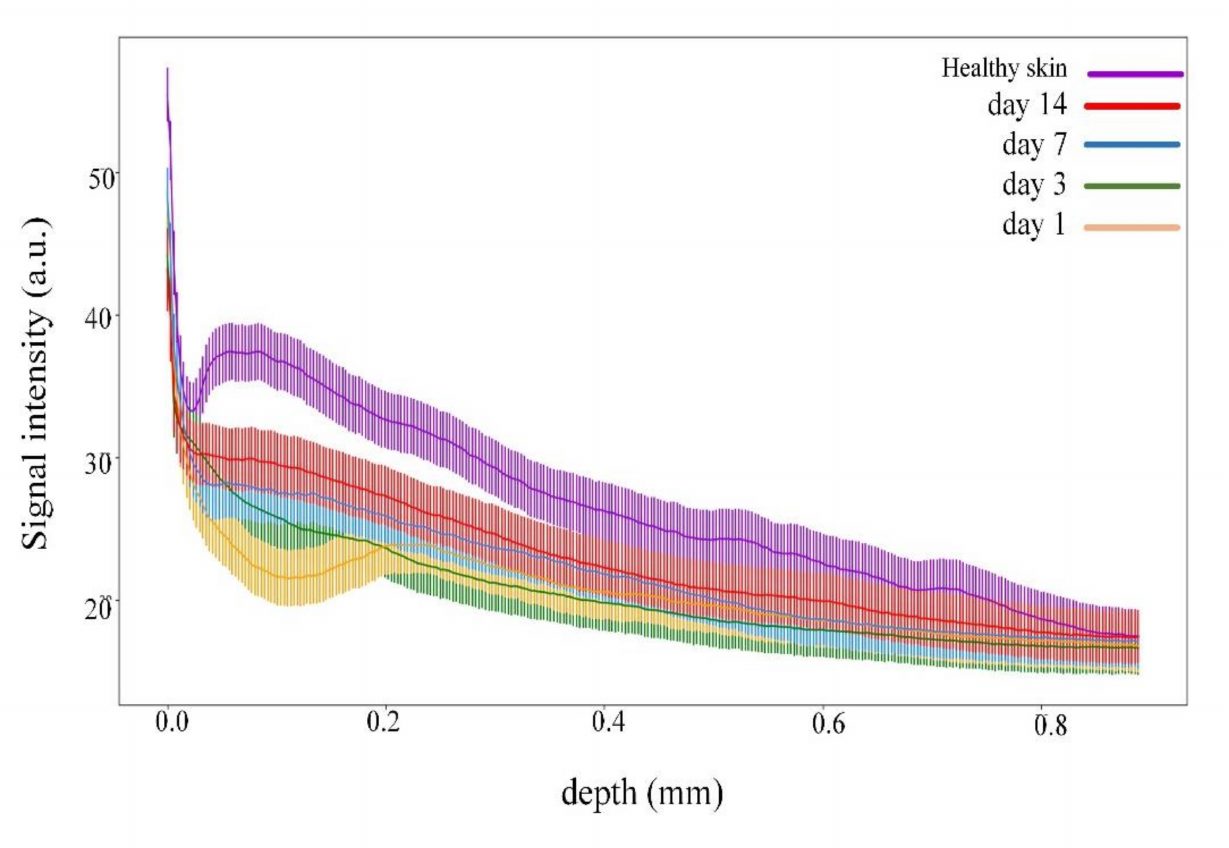
Figure 6. Dependence of signal intensity on depth for the control group during wound